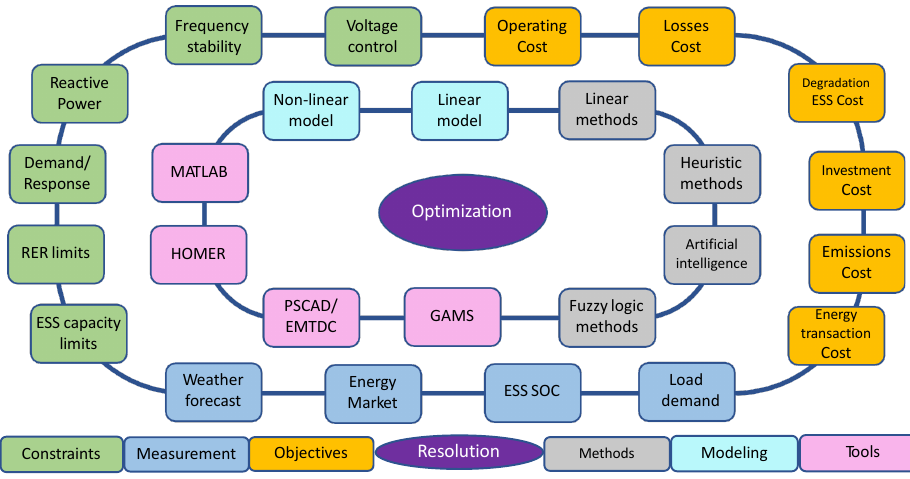
Figure 12. Energy management strategies of